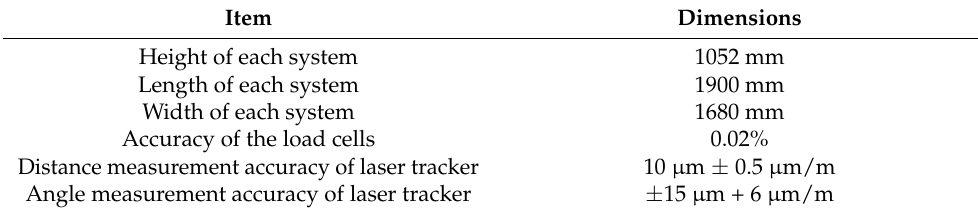
Table 1. Major dimensions of the systems.